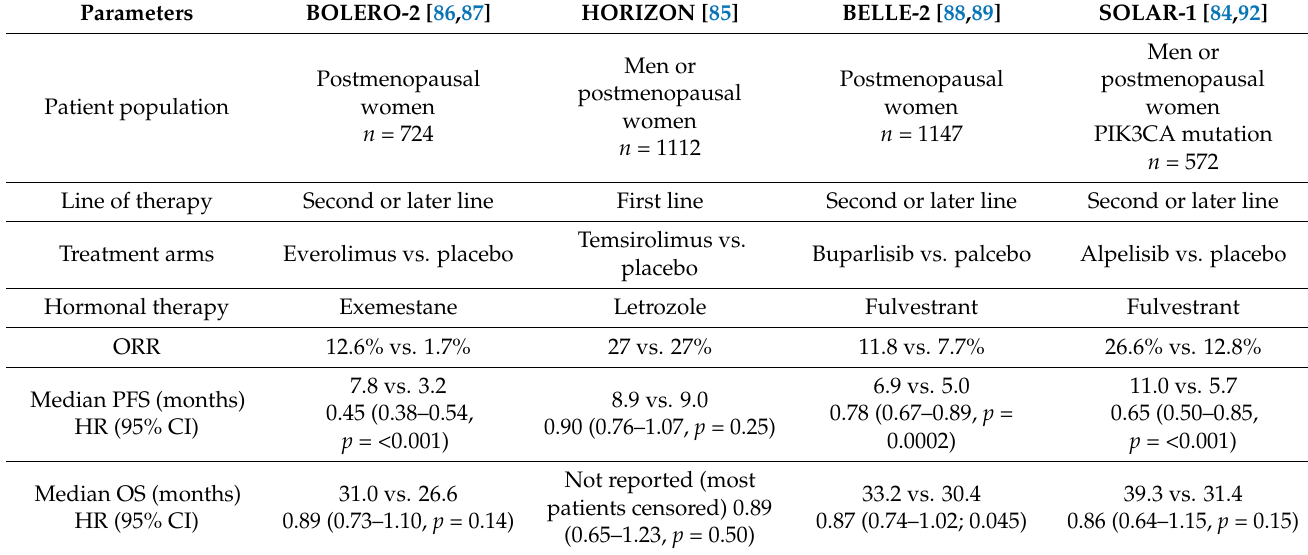
Table 5. Clinical data of key Phase III trials involving PI3K/Akt/mTOR pathway inhibitors with hormonal therapy as first or subsequent line treatment for patients with HR+ advanced breast